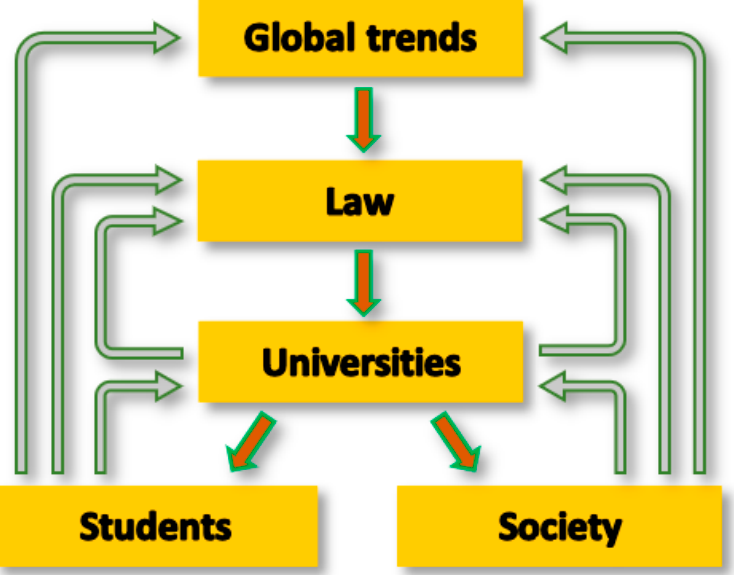
Figure 5. Diagram of propagation elements of development and principles of the circular econ- omy.